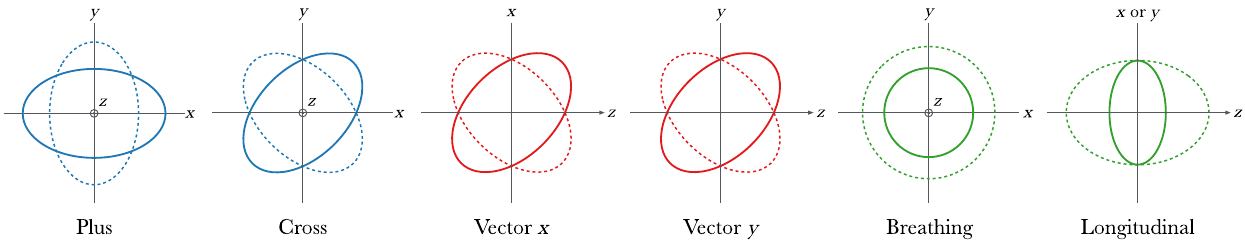
FIG. 1. Deformation of a ring of freely falling test particles under the six gravitational-wave polarizations allowed in general metric theories of gravity. Each wave is assumed to propagate in the z direction (out of the page for the plus, cross, and breathing modes; to the right for the vector- x , vector- y , and longitudinal modes). While general relativity allows only for two tensor polarizations (plus and cross), alternate theories allow for two vector ( x and y ) and/or two scalar (breathing and longitudinal) polarization